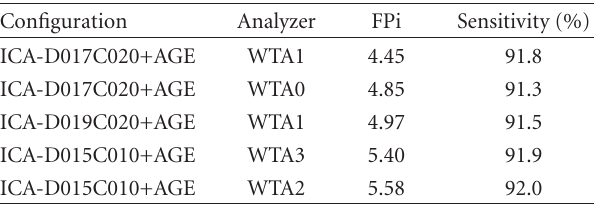
Table 2: Performance results on the BCRP CALC 1 subset of the five system configurations that generate the lowest false positives per image and provide a sensitivity higher than 90%.